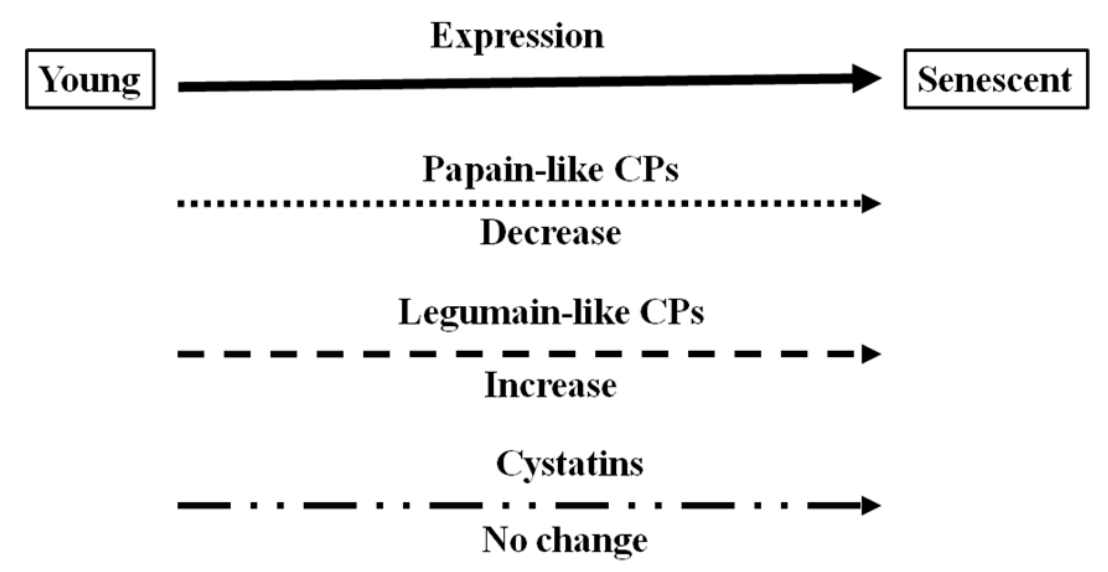
Figure 8. Schematic diagram of different types of cysteine proteases (CP) and cystatins expressed in soybean nodules at different development